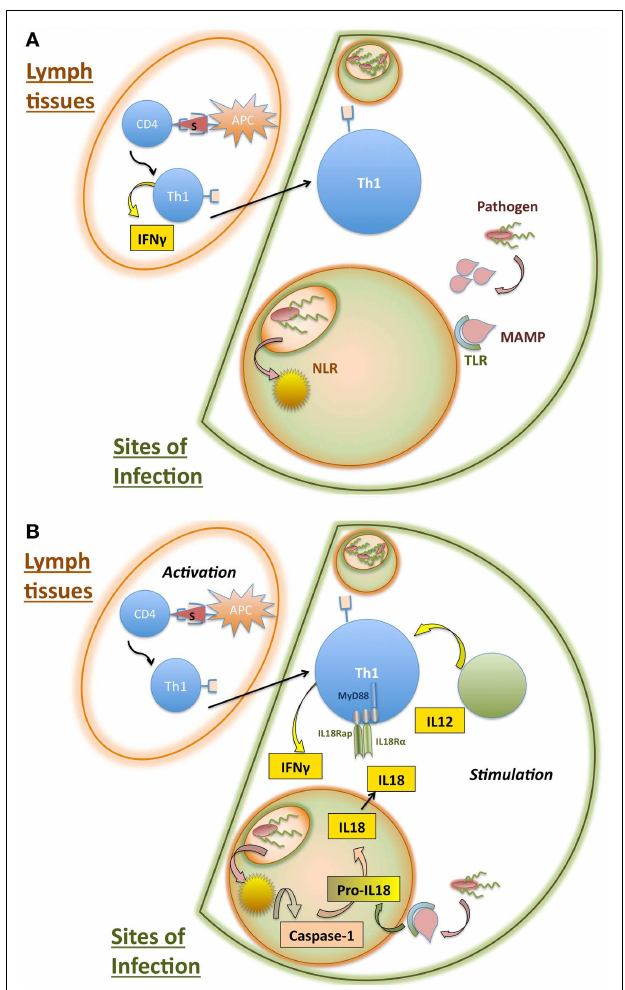
FIGURE 2 | Partial mechanism for non-cognate stimulation of activated CD4T cells . (A) Initiation of innate and adaptive immune responses during intracellular infections. CD4T cells are initially activated in lymph tissues upon recognition of particular peptide antigens presented by antigen presenting cells (APCs). During intracellular infections, the presence of IFN- γ and IL-12 results in differentiation of these activated CD4T cells into Th1 cells, which produce IFN- γ .TheTh1 cells then traffic to sites of infection, where they require additional stimulation to induce production of effector cytokines. Meanwhile, sites of infection experience inflammation elicited by innate recognition of pathogens. Pattern recognition receptors such as toll-like receptors (TLRs) and nod-like receptors (NLRs) recognize conserved products of infection, called microbe-associated molecular patterns (MAMPs). (B) Innate inflammation stimulatesTh1 cells to amplify effector response at sites of infection.TLR recognition of innate ligands results in the upregulation of pro-IL-18, while NLR recognition of infection activates caspase-1. Caspase-1 cleavage of pro-IL-18 into the mature form of the cytokine IL-18 allows secretion. IL-18 receptor is required byTh1 cells for non-cognate elicitation of IFN- γ . CD4T cell stimulation at sites of infection likely involves additional cytokine pathways, including IL-12, which can act synergistically with IL-18 to stimulateTh1 cells.